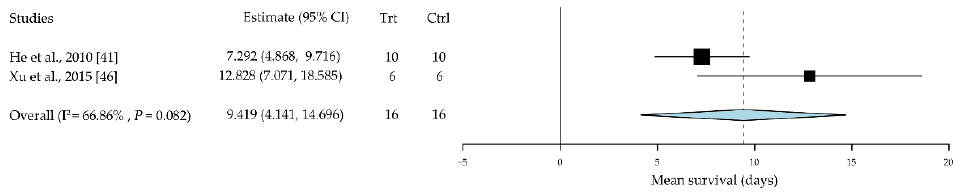
Figure 5 . Regulatory T cells prolong corneal allograft survival. CI, confidence intervals; EV, event; Trt, treatment; Ctrl, control.